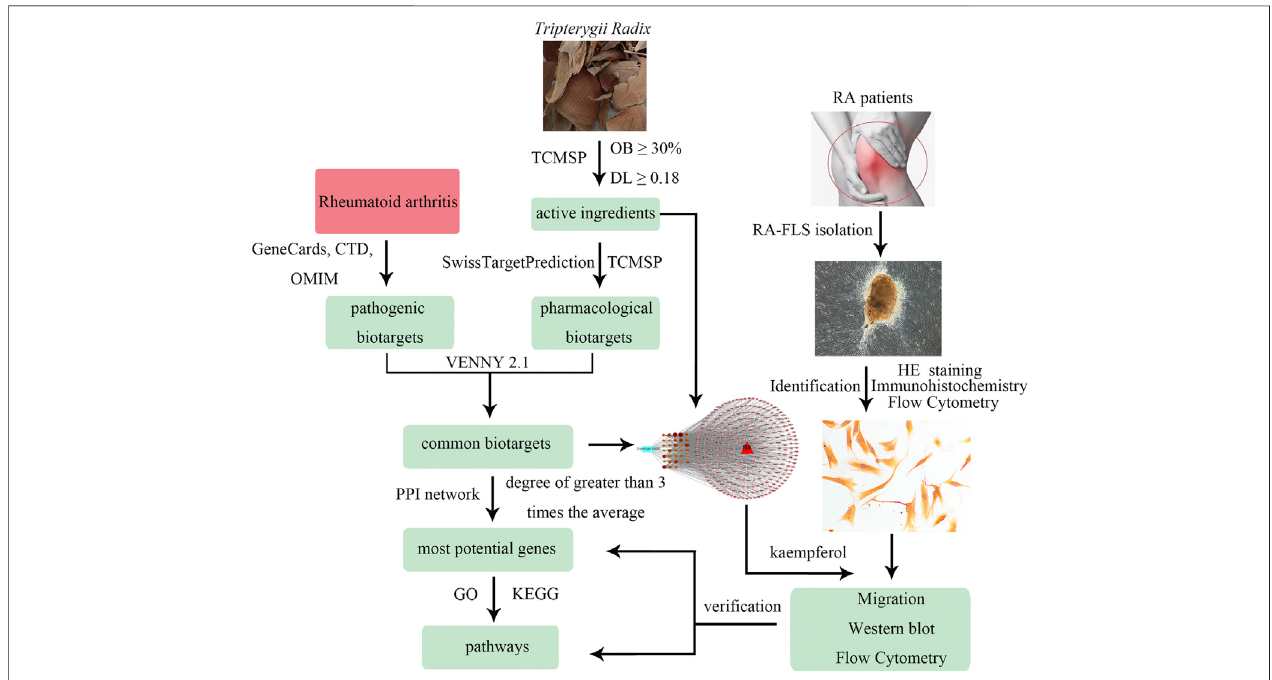
FIGURE 1 | The work fl ow of this